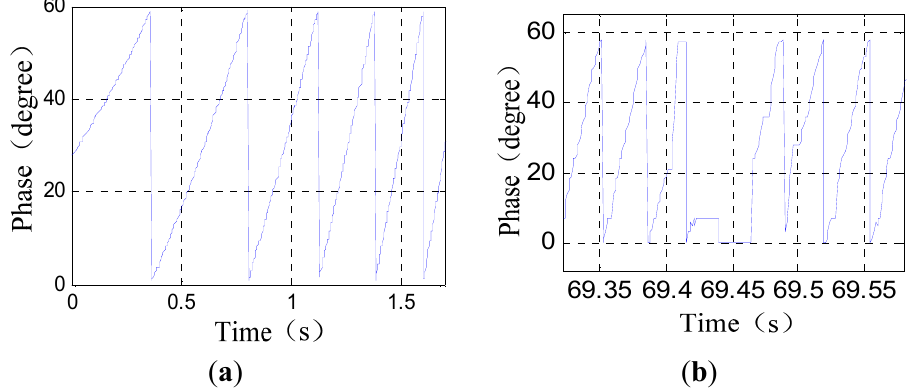
Figure 4. ( a ) Normal phase signal; ( b ) phase signal near a large joint